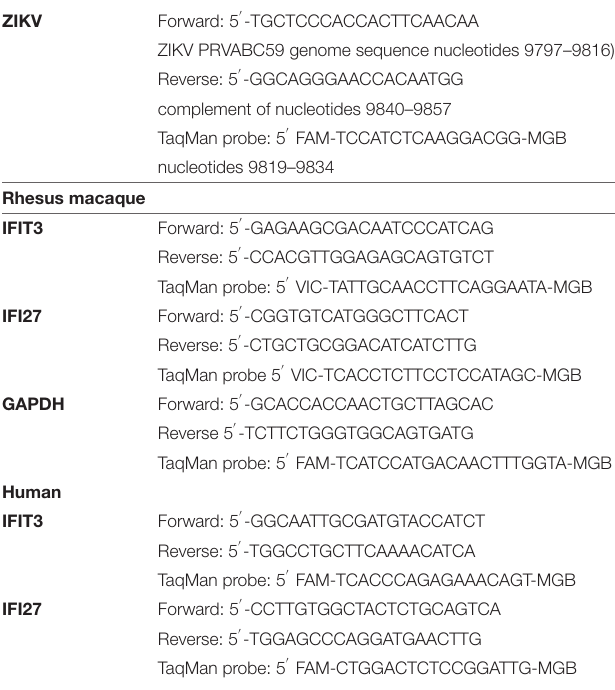
TABLE 1 | Primer and TaqMan probe